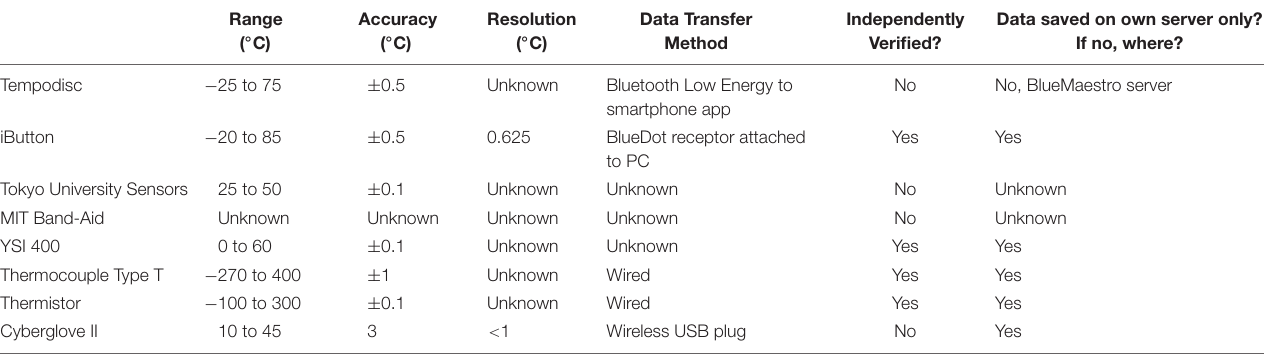
TABLE 1 | Specifications of possible sensor devices to be used in co-thermoregulation research and